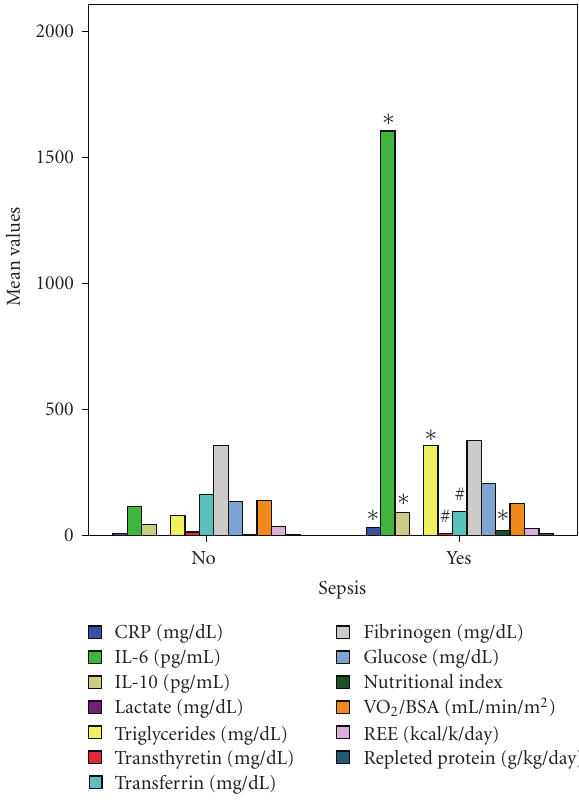
Figure 1: Comparison of metabolic monitor measurements, cytokines, and nutritional markers between patients with and without systemic inflammatory response syndrome (SIRS) (scale type power: exponent 0.5). In the presence of SIRS significantly increased ( ∗ ) were: C-Reactive Protein (CRP), Interleukin-6 (IL-6), Interleukin-10 (IL-10), nutritional index, and triglycerides ( t -test for unpaired data). Significantly decreased (#) despite a higher protein intake: transferrin and transthyretin. Did not di ff er com- pared to the non-SIRS patients: lactate, glucose, fibrinogen, Oxygen Consumption (VO 2 ), and Resting Energy Expenditure (REE). BSA: Body Surface Area.